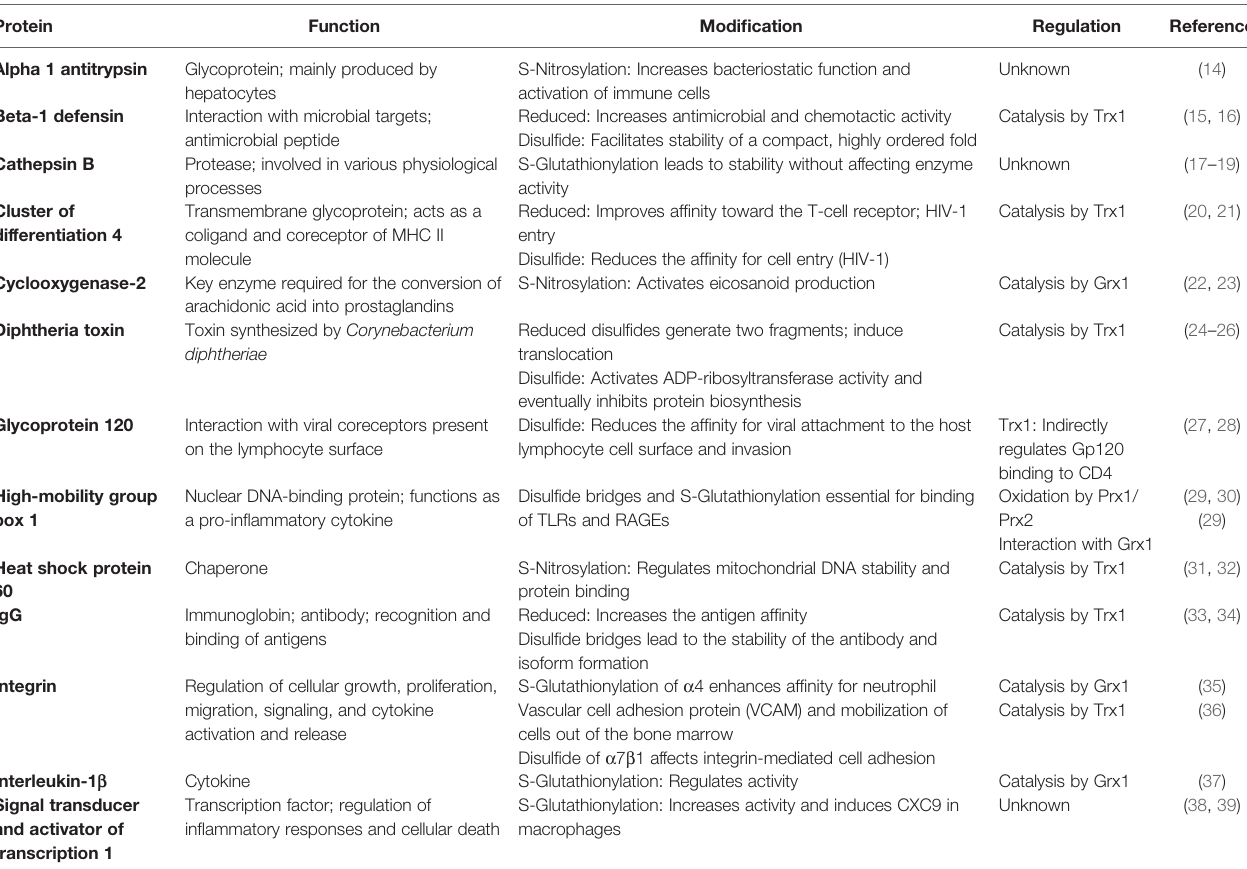
TABLE 1 | Posttranslational thiol modi fi cations of proteins involved in in fl ammation and infection. Protein